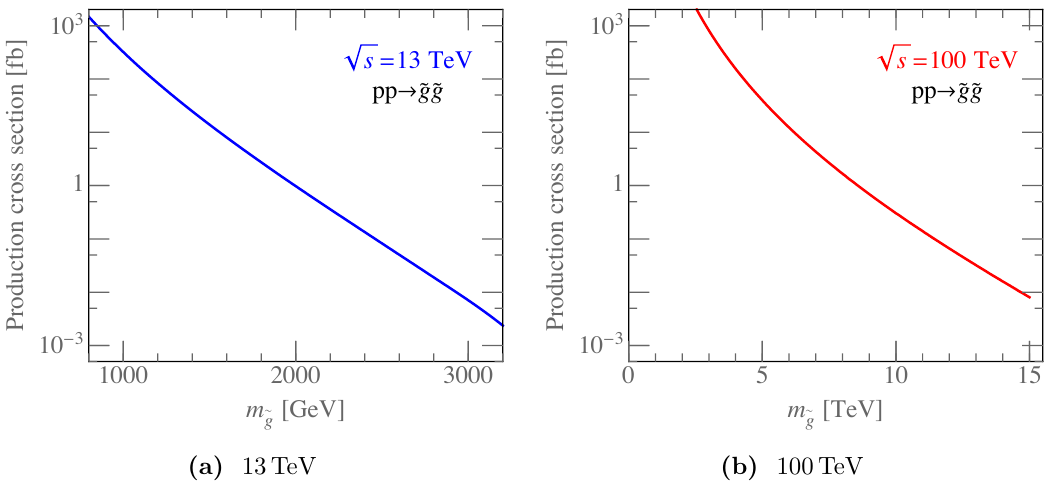
Figure 2. The pair-production cross sections of gluinos as functions of the gluino